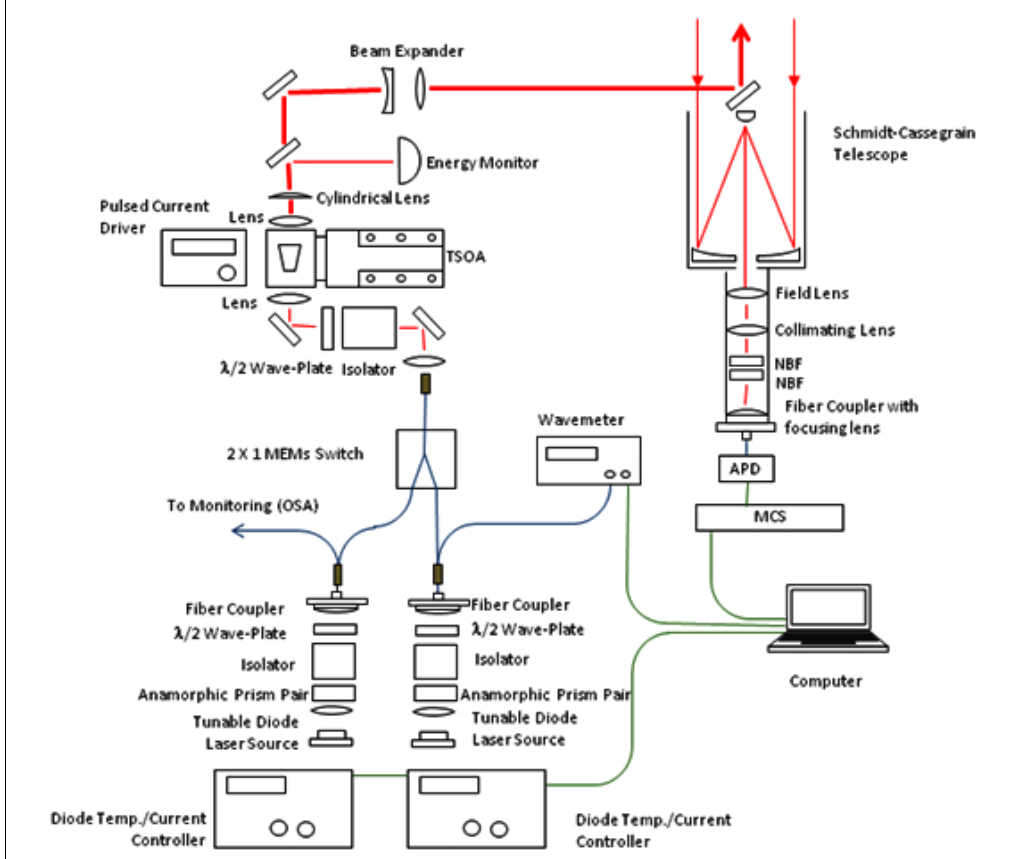
Figure 1. Schematic of the diode laser based DIAL instrument. The Laser transmitter is based on two DBR lasers used to injection seed a TSOA in a MOPA